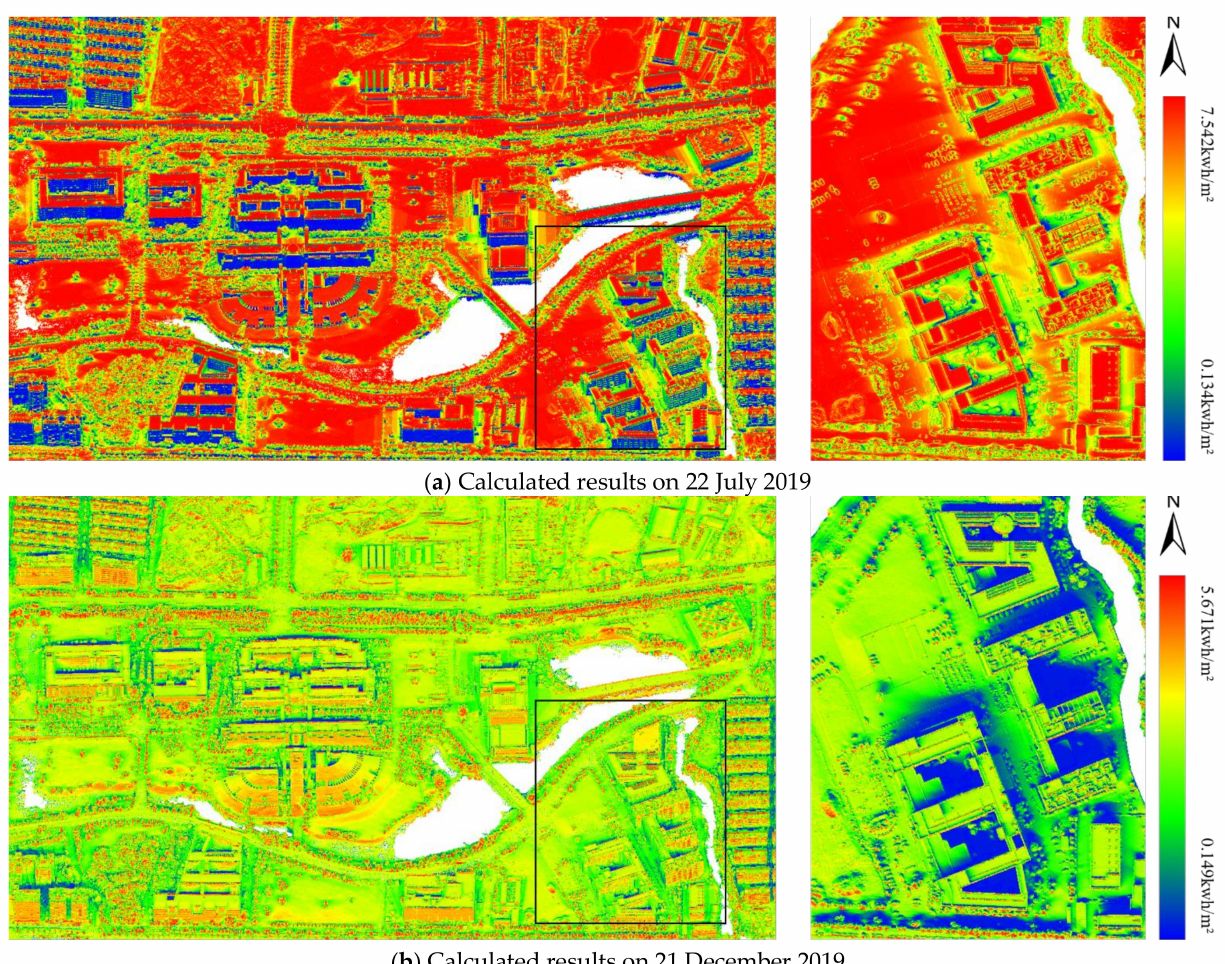
Figure 10. The cumulative solar irradiance received by the surface of the study